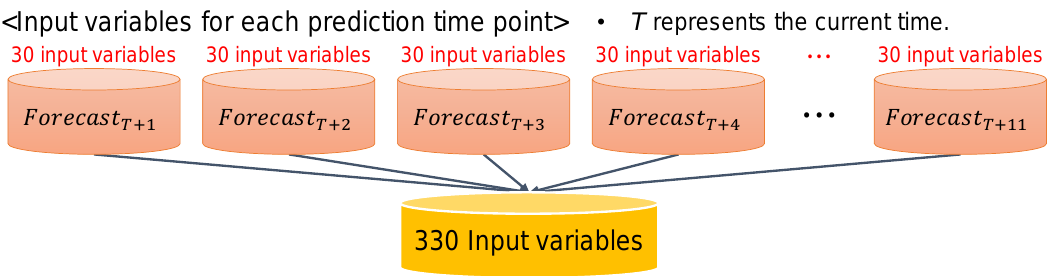
Figure 3. Input variable configuration for multistep-ahead (MSA) global solar radiation forecasting.